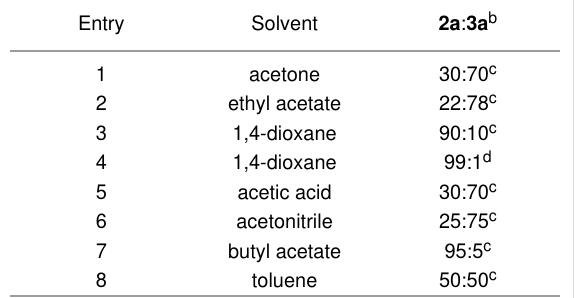
Table 2: Reaction of FPD 1a with thiourea at reflux in various solvents. a